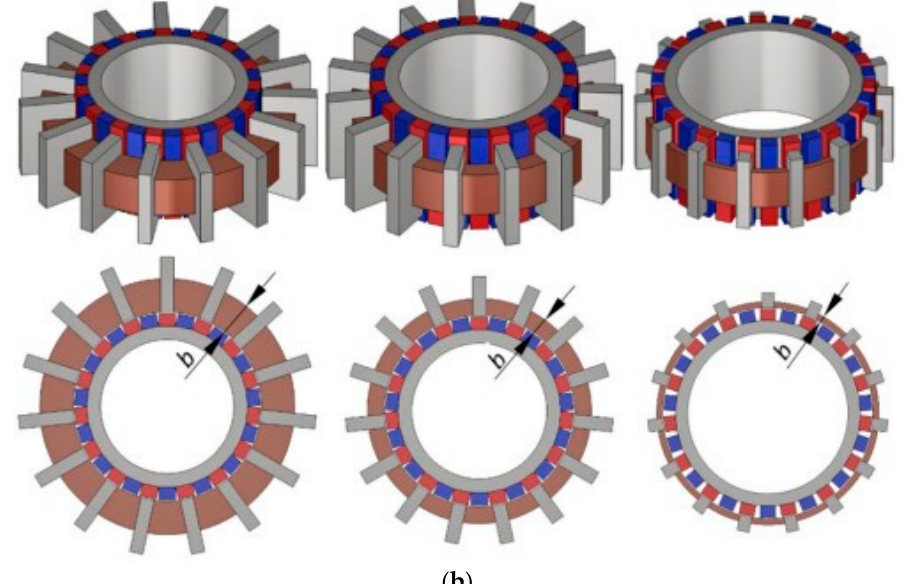
Figure 10. 3D FEM models of the outer and inner rotor TFMs with various coil height parameters: ( a ) TFM with an outer rotor and ( b ) TFM with an inner rotor.